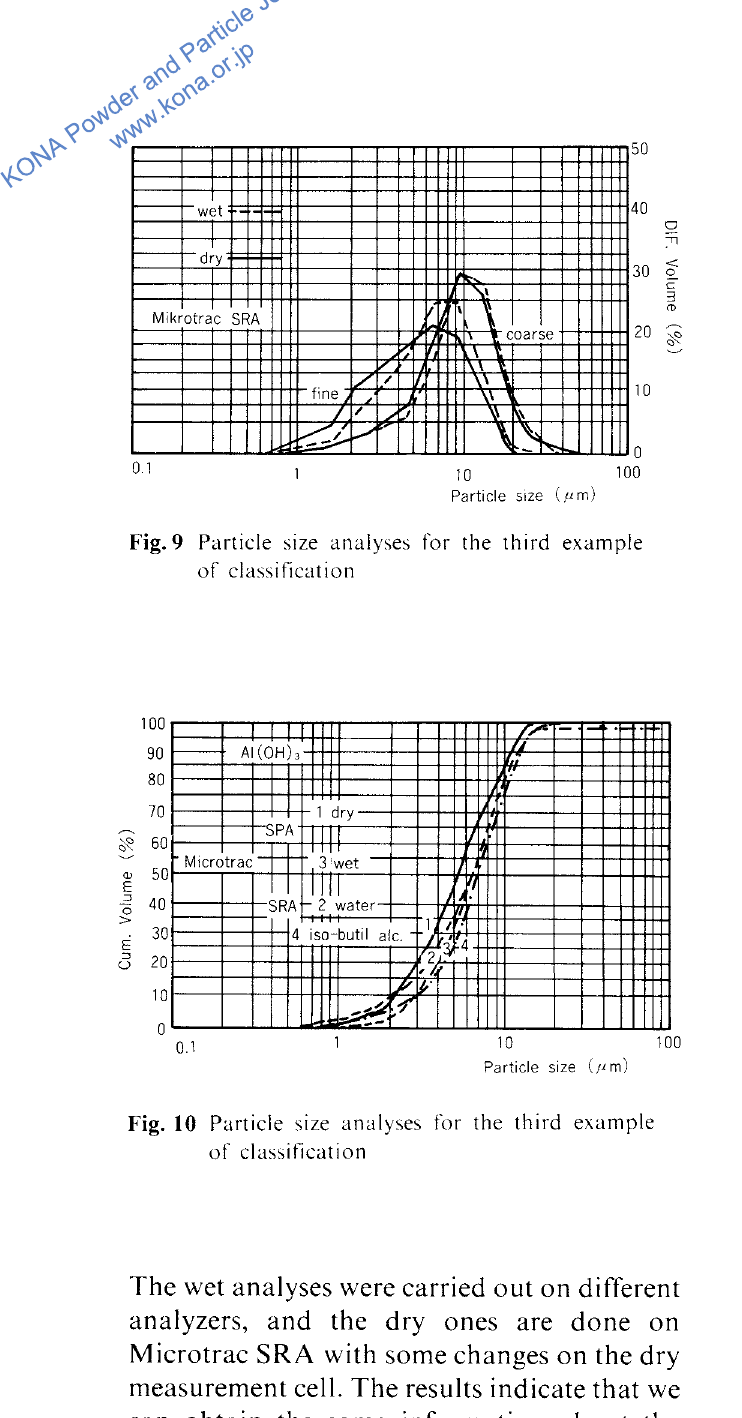
Fig. 10 Particle size analyses for the third example of classification